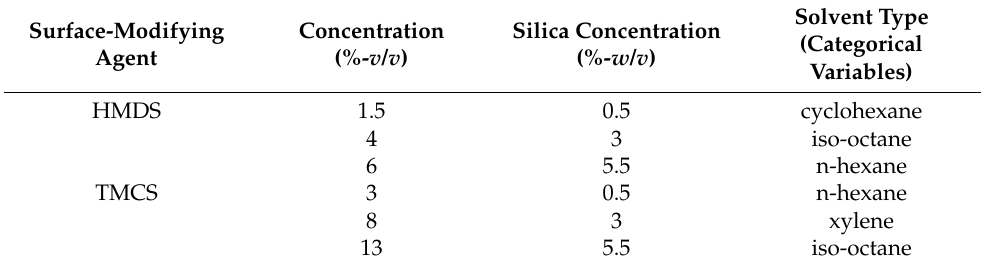
Table 1. Variables experiment for full factorial design of 3